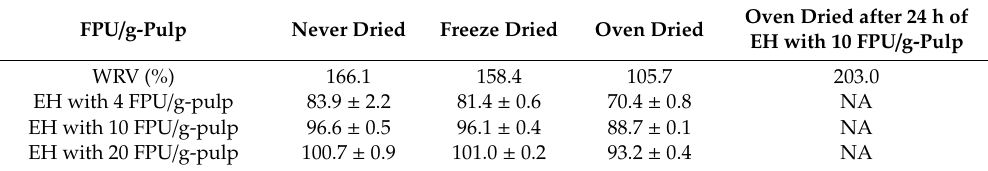
Table 3. Water retention value (WRV) and enzymatic digestibility depending on